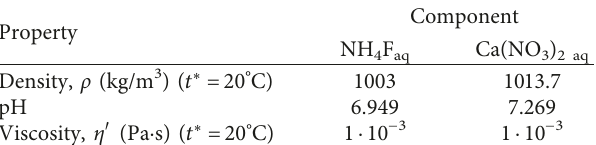
Table 2: Properties of the